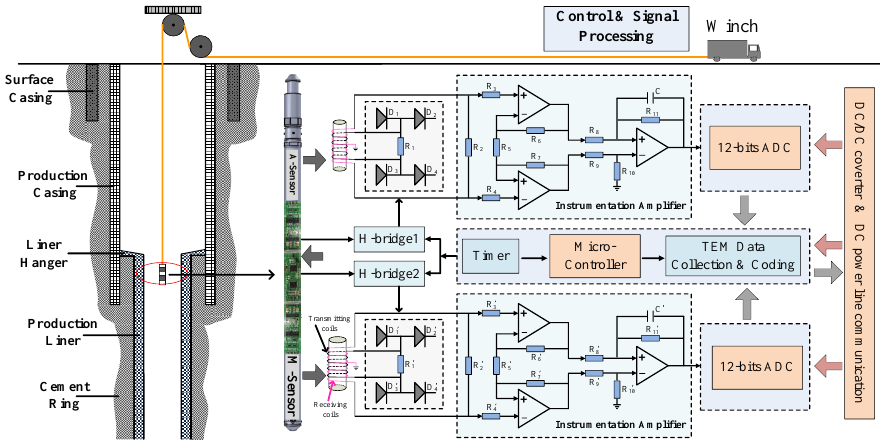
Figure 6. Auxiliary sensor-based borehole transient electromagnetic (TEM) system in a multistring oil well. DC, direct current. ADC, analog-to-digital converter.